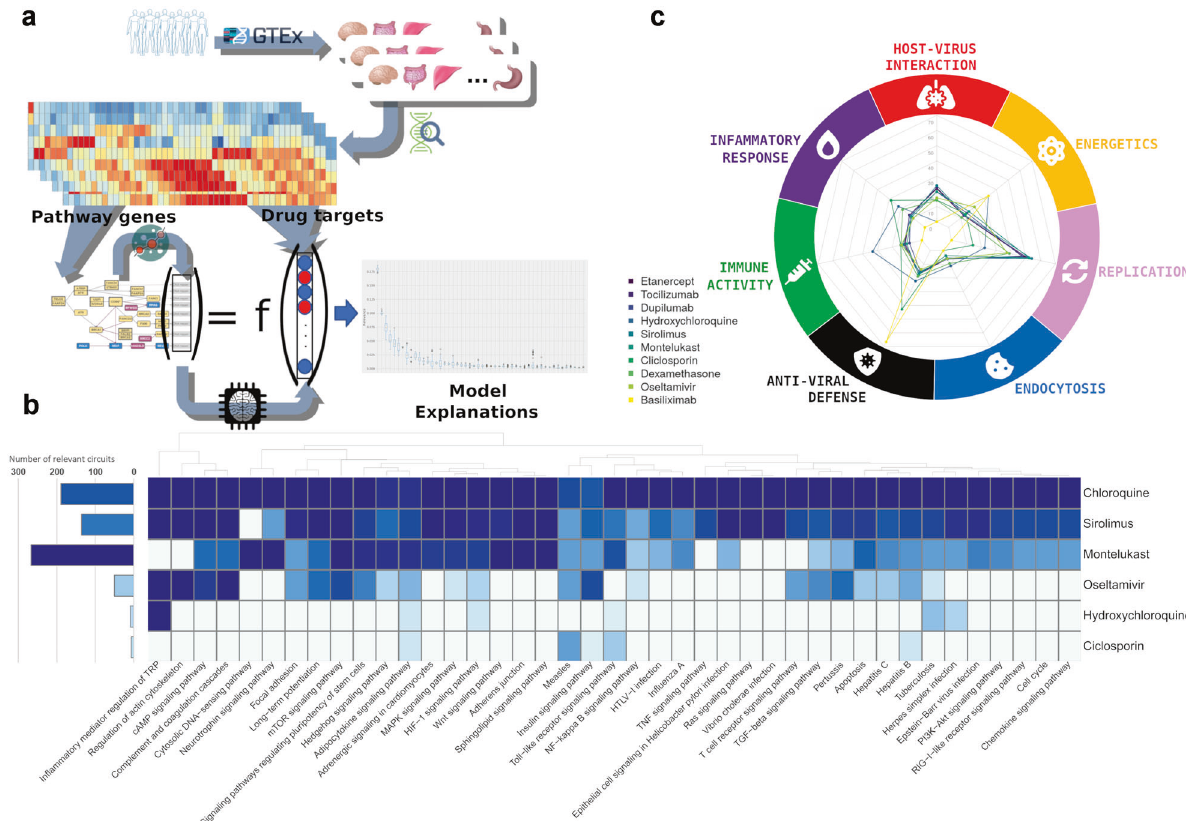
Fig. 1 Summary of the drug repurposing strategy and the results obtained. a Schema of the procedure followed for fi nding drug targets that affect the COVID-19 disease map. b Two different patterns of circuits affected by six drugs (see text). c Radar plot representing the impact of the most relevant drugs listed in Supplementary Table S3 over the different COVID-19 hallmarks, quanti fi ed as the number of circuits of the corresponding hallmark are potentially